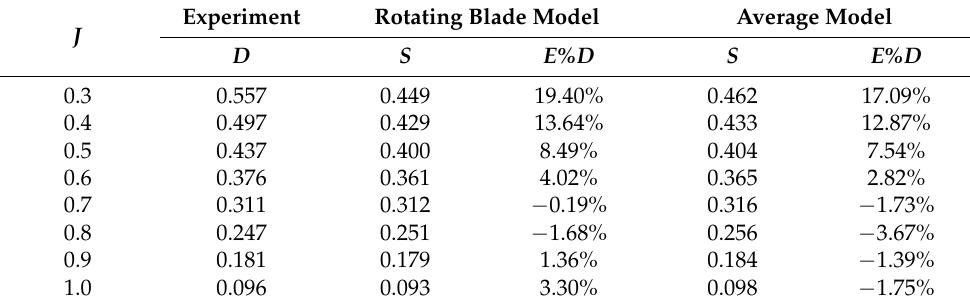
Table 5. Error analysis for propeller torque coefficient KQ